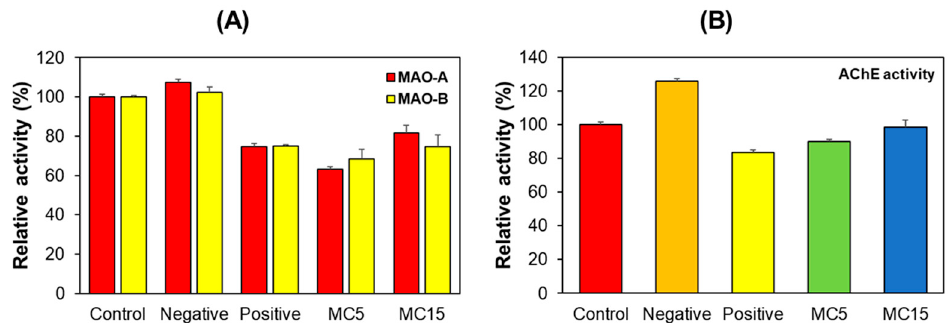
Figure 4. Effect of MC on MAO-A, MAO-B, and AChE activities relating to neurotransmitters in hippocampus tissues. Results are expressed as mean ± SEM from triplicate experiments. ( A ) MAO- A and MAO-B activities; ( B ) AChE activity.